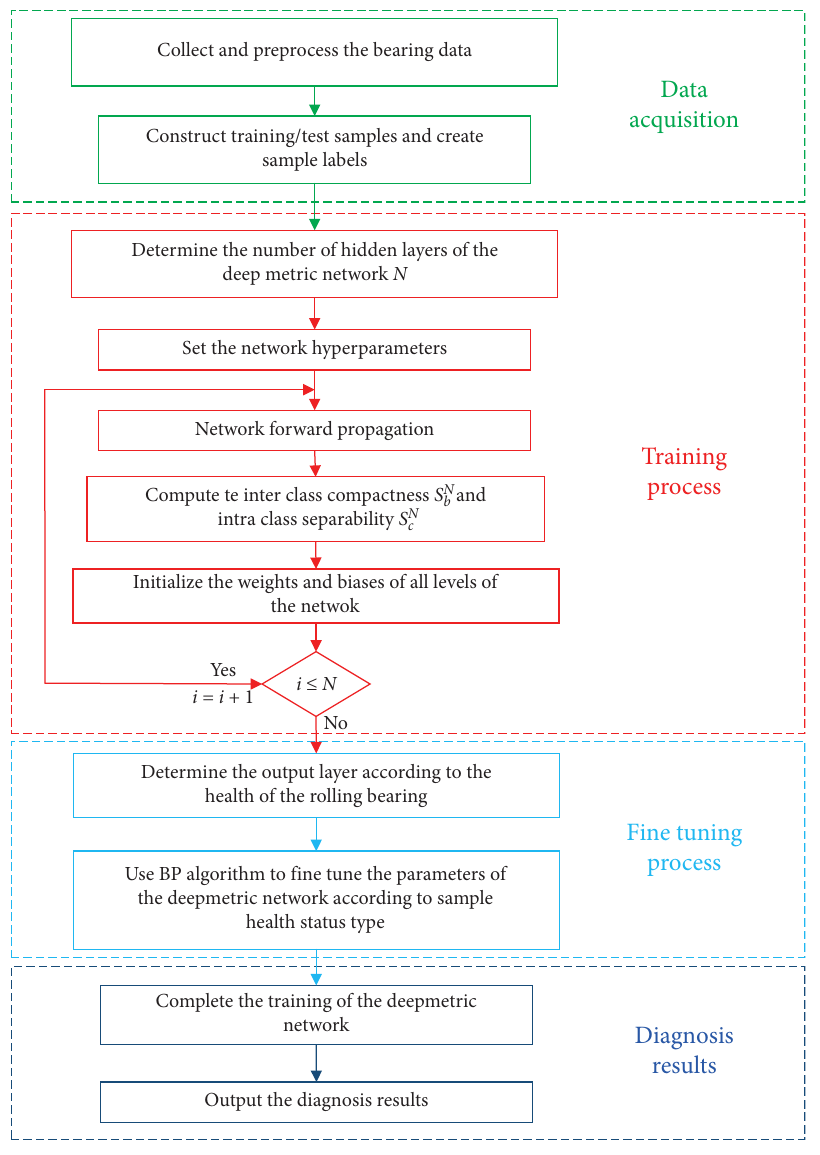
Figure 3: Flowchart of the proposed method. Table 1: Description of bearings